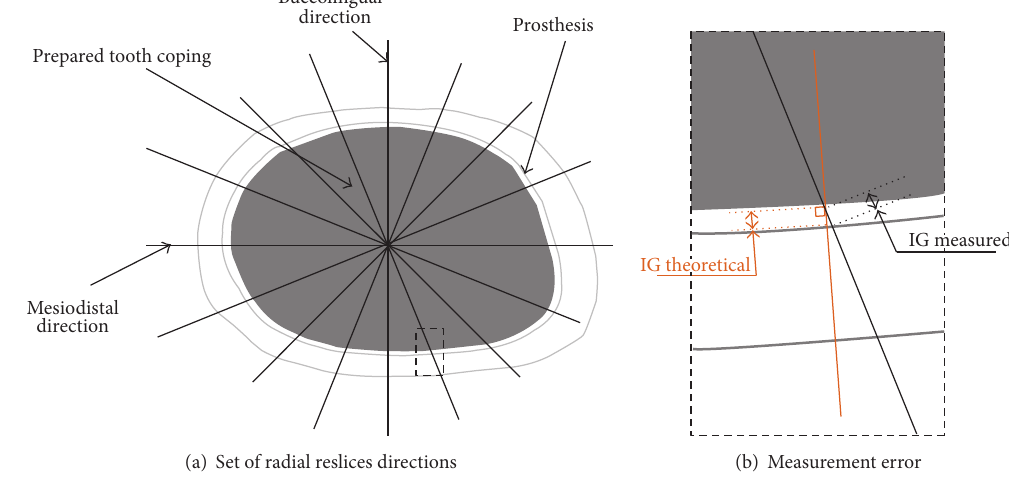
Figure 4: Set of radial slicing planes containing PA (a) planes directions and (b) measurement